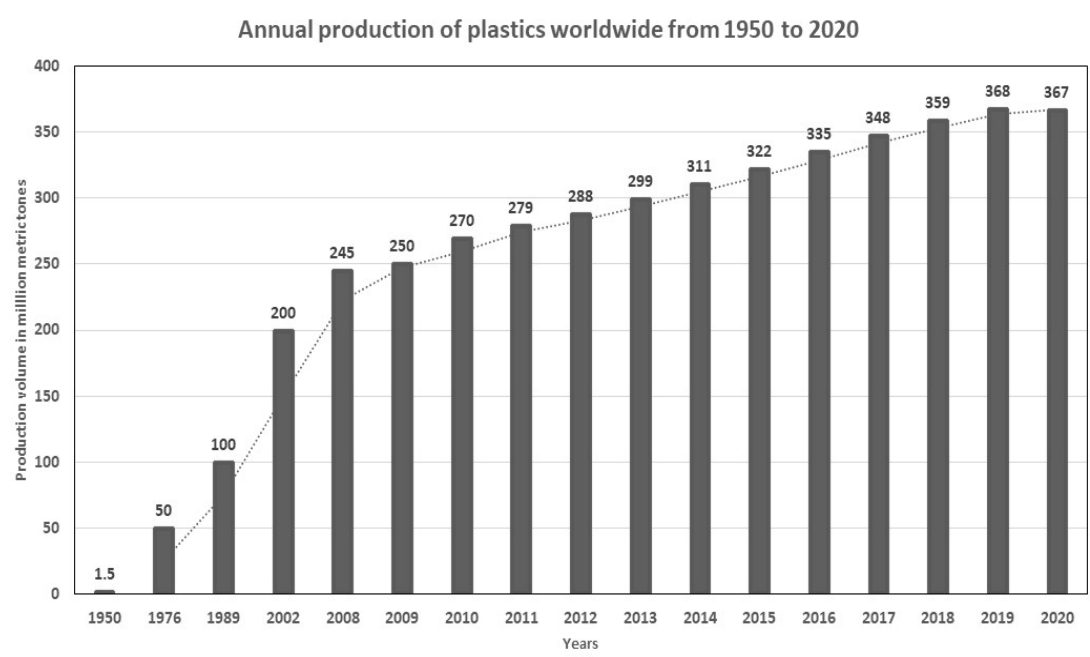
Figure 1. Annual production of plastic worldwide from 1950 to 2020 (Plastics Europe, 2020).